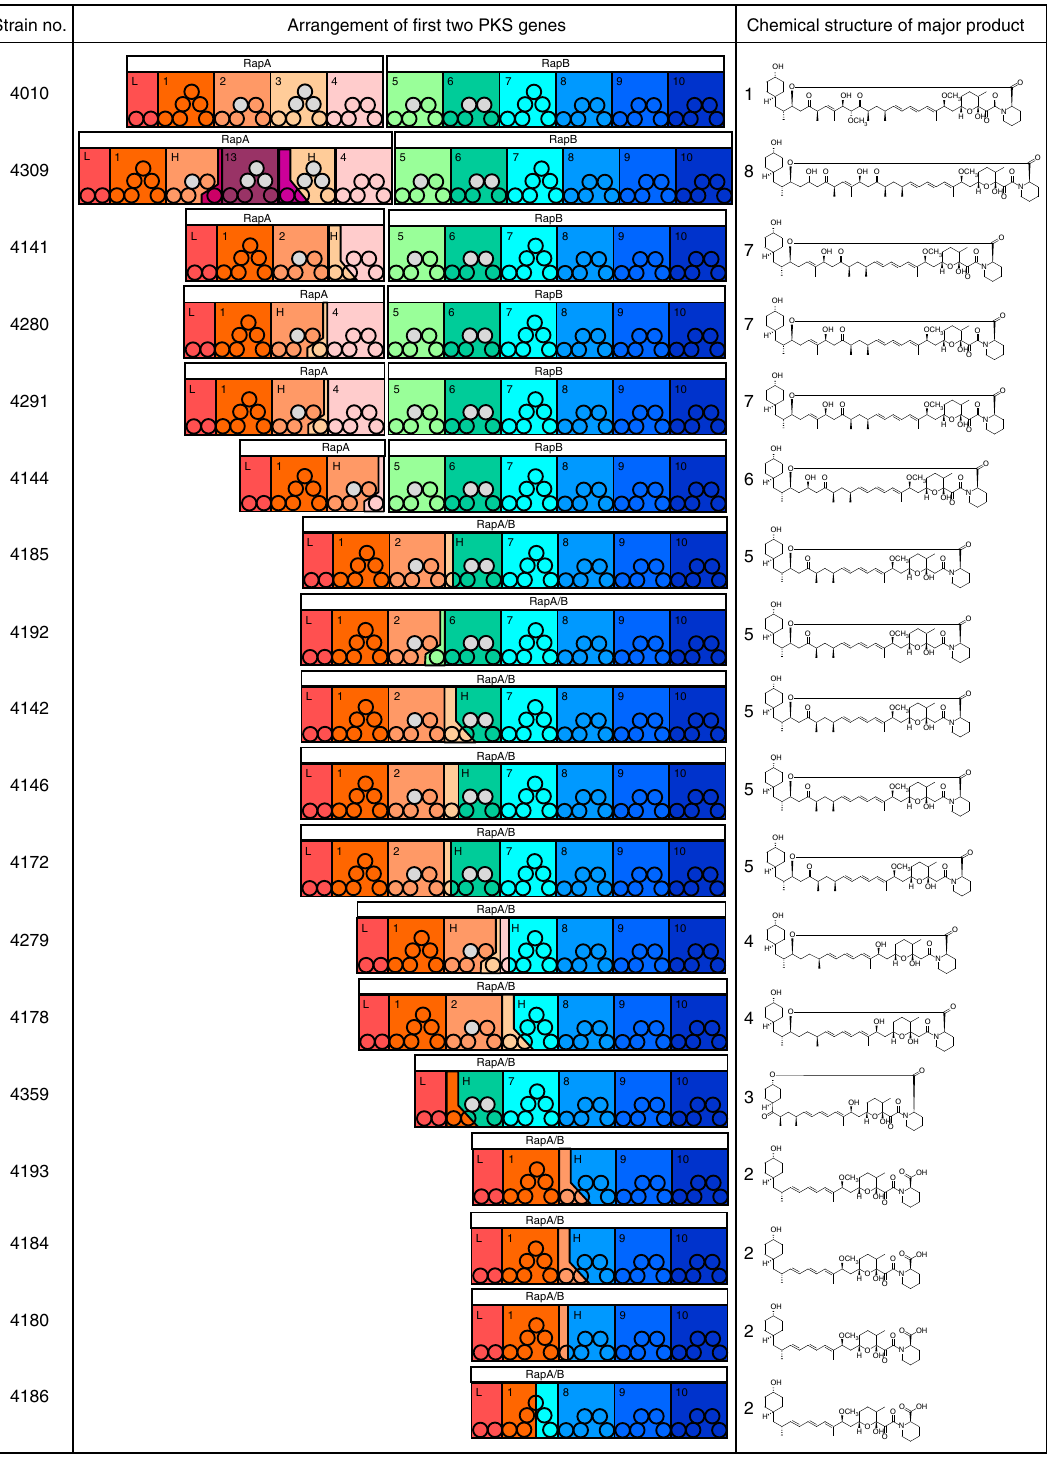
Fig. 3 Comparison of the chemical structures isolated from each of the novel strains and the rapamycin PKS modular alignment for each of the sequenced PKS genes. Circles show enzymatic domains in each module. Modules 11 – 14 encoded by RapC are not